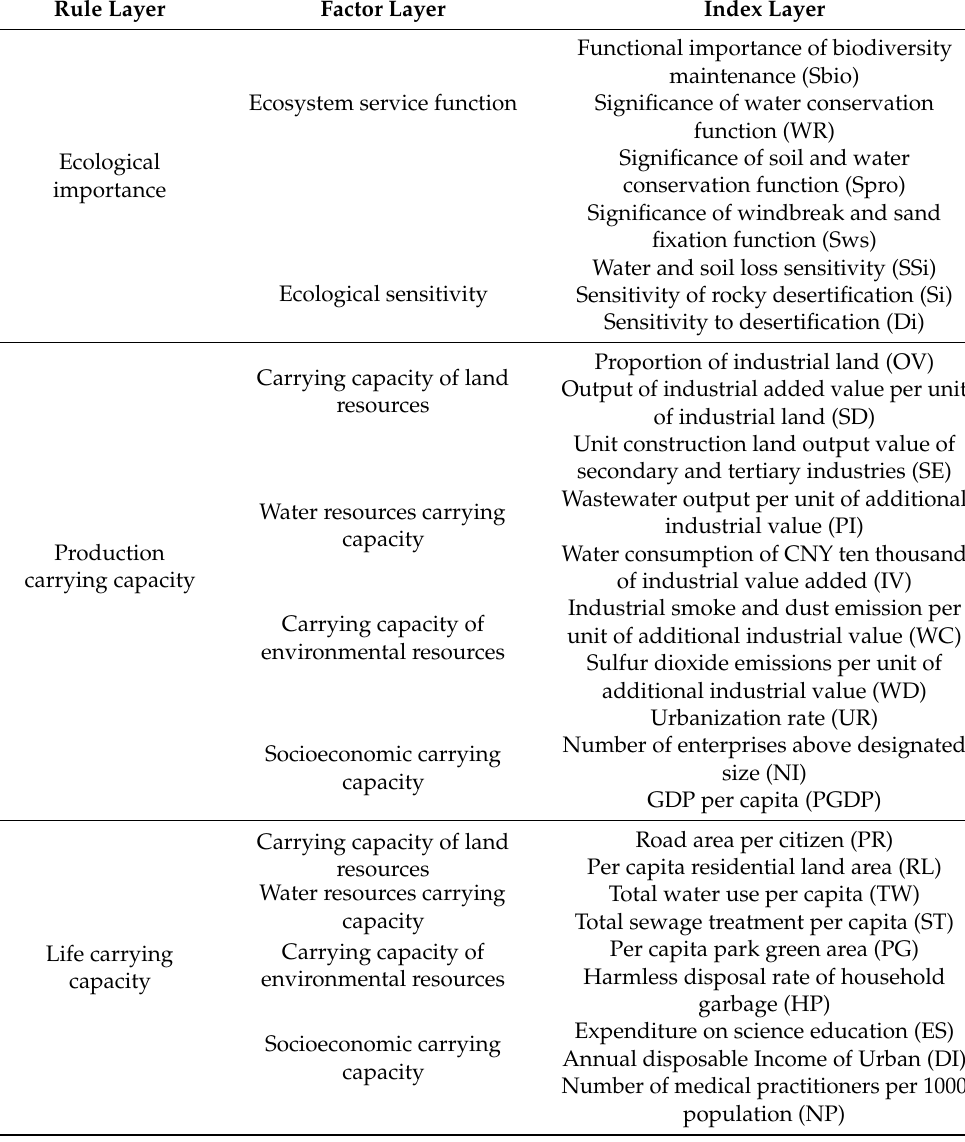
Table 1. Resource and environment carrying-capacity evaluation index